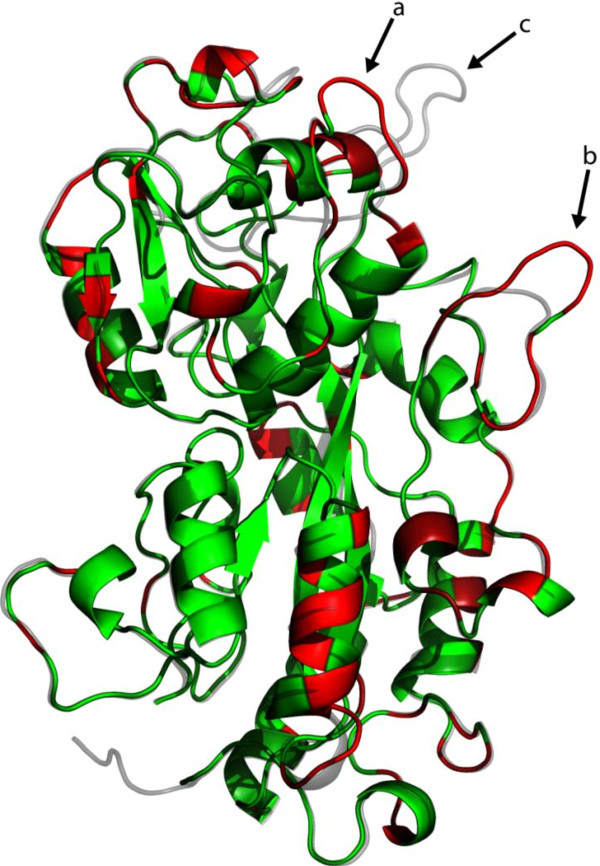
The unique areas of PA14DING in comparison to PfluDING. The LOMETS predicted model of PA14DING was overlaid with the crystal structure of PfluDING. The differences in sequence is between the two proteins were mapped red on the PA14DING model. Green: PA14DING model; Grey: PfluDING crystal structure. Differences in external loops are highlighted by arrows (a; residues 162–167) and (b; residues 269–275). Arrow c represents a loop present in PfluDING but absent in PA14.